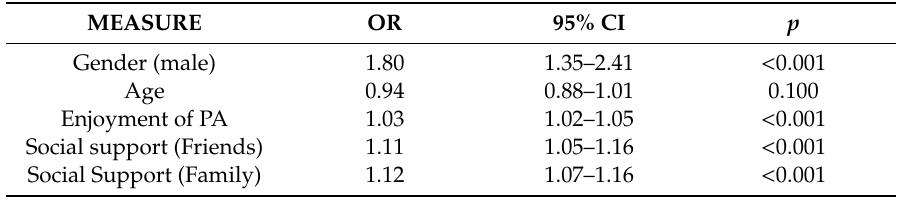
Table 4. Logistic regression predicting likelihood of meeting the physical activity